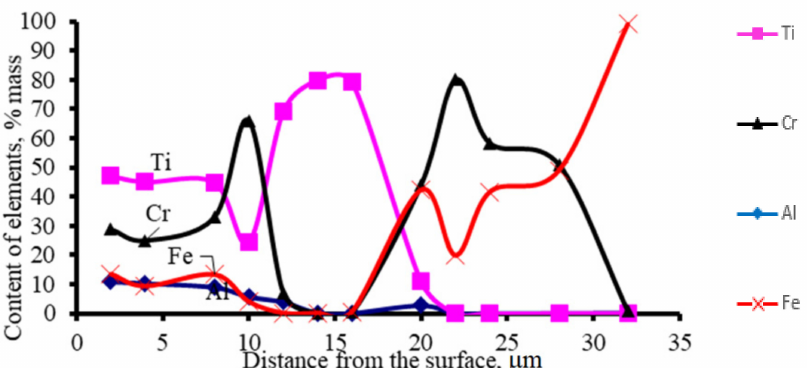
Figure 6. Elements distribution by the thickness of the coating of AISI W1-7 steel with a layer of σ - phase; Cr 7 C 3 and Cr 23 C 6 after titanium aluminizing: chromizing (1050 ◦ C, 4 h); titanium aluminizing (1050 ◦ C, 4